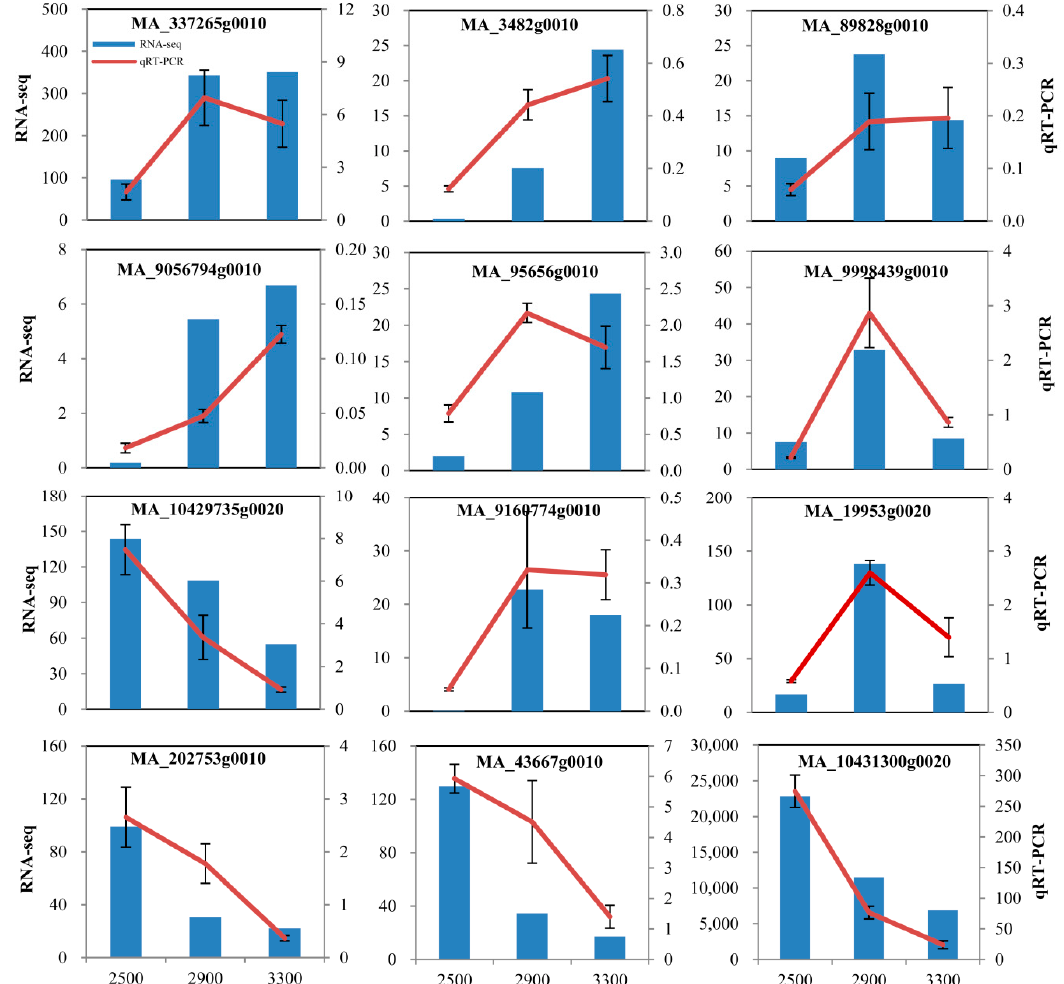
Figure 5. Verification of RNA sequencing (RNA-Seq) results by quantitative real-time PCR (qRT-PCR).